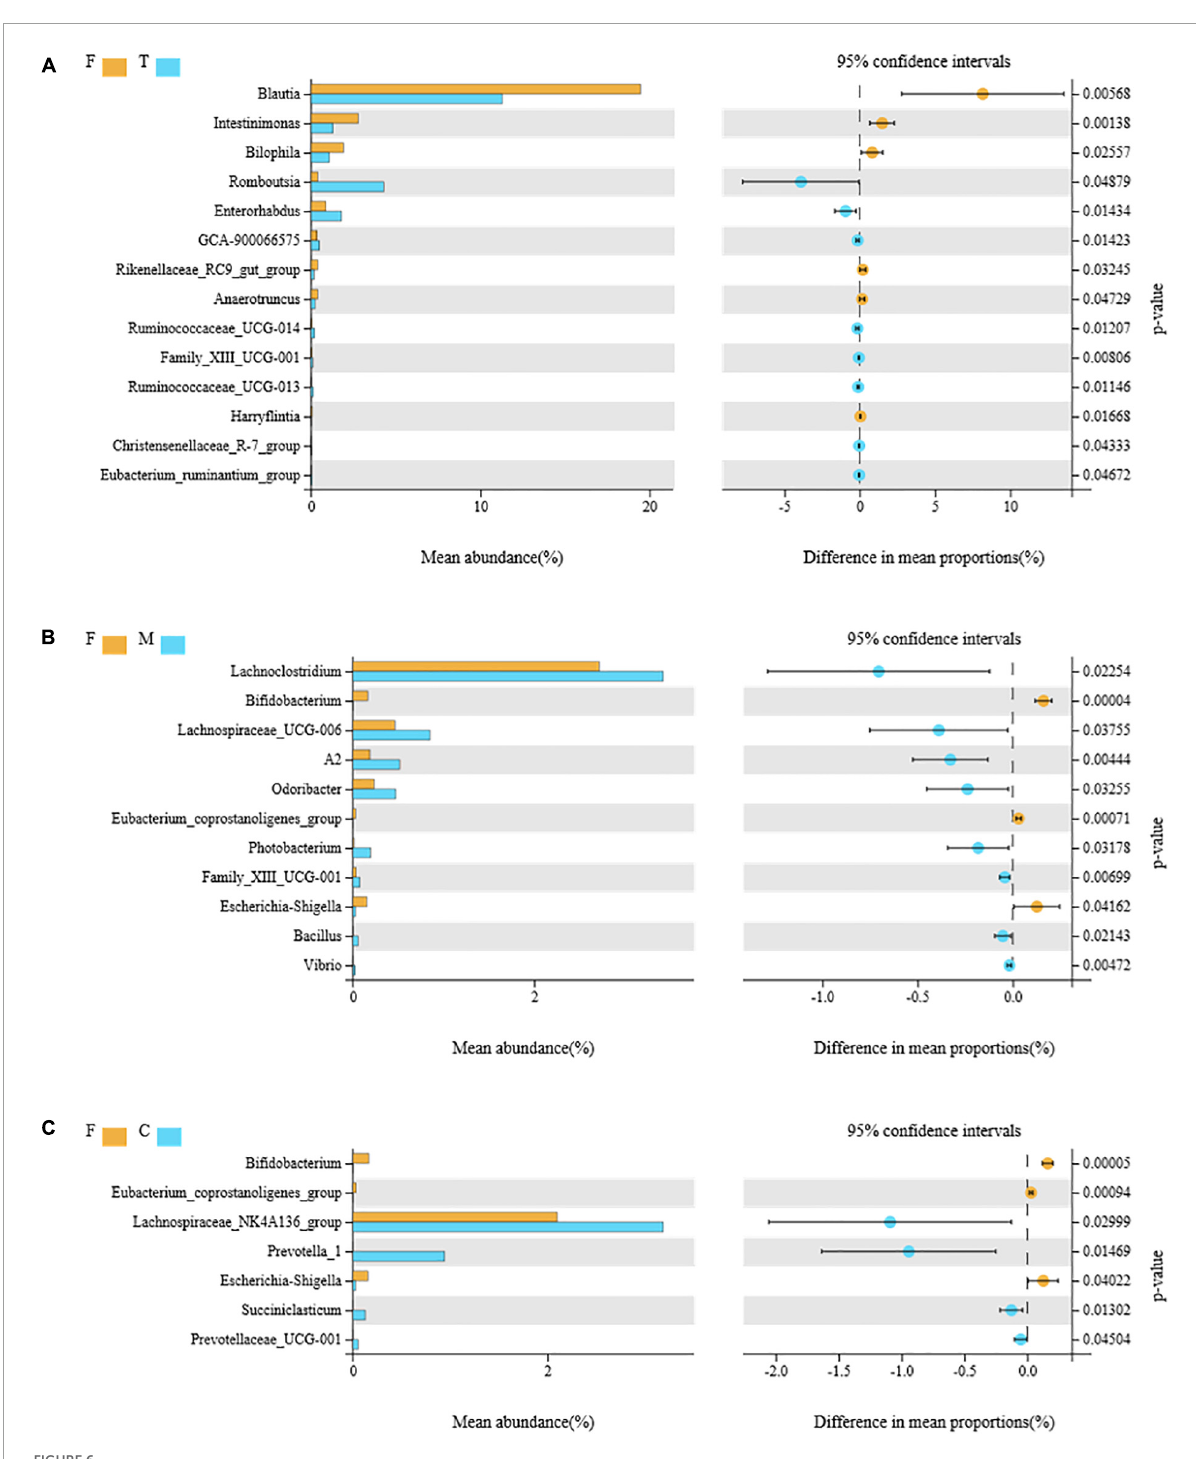
FIGURE6 Comparison of the differential intestinal bacteria between the F group and green tea powder group at the genus level ( p < 0.05). (A) Comparison of the differential intestinal bacteria between the F group and T group. (B) Comparison of the differential intestinal bacteria between the F group and M group. (C) Comparison of the differential intestinal bacteria between the F group and C